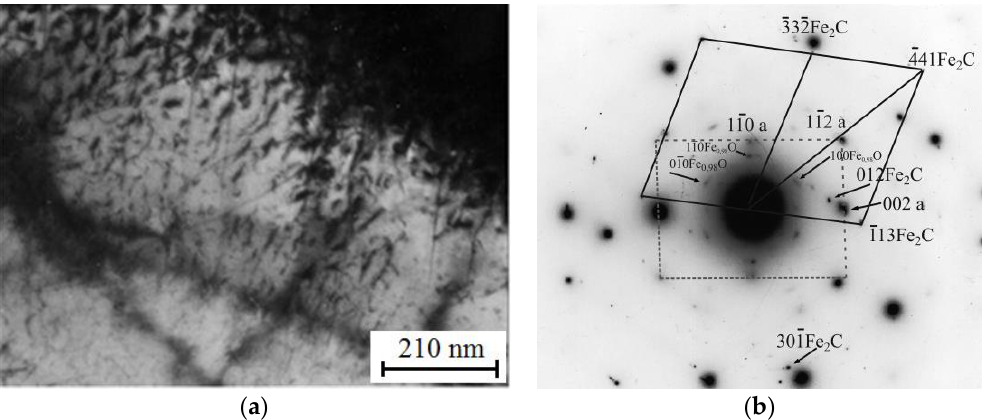
Figure 8. ( a ) Bright-field image of the ferrite structure in the coating with the estimated content of TiCN 0.15 wt%; ( b ) the corresponding selected diffraction pattern of the region showing the [ 1̅1̅0 ] zone axis of ε -carbide and the [00 1̅ ] zone axis of iron oxide parallel to the (110) zone axis of α -Fe. Comparison of the interplanar spacings for diffraction spots with hexagonal sym- metry with the interplanar spacings of the compounds listed in the JCPDS (Joint Commit- tee on Powder Diffraction Standards) file showed that hexagonal iron oxide Fe 0.98 O with lattice parameters a = 2.901 Å and c = 7.532 Å is closest to the experimental value. The zone axis of the oxide is [001].